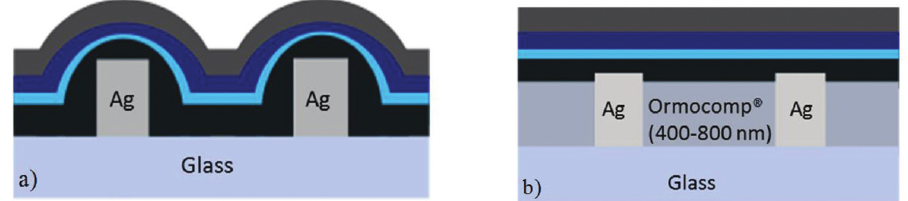
Figure 10. ( a ) Schematic representation of the PLED stack with non-embedded Ag-ink lines; Figure 10. ( a )Schematic representation of the PLED stack with non-embedded Ag-ink lines;